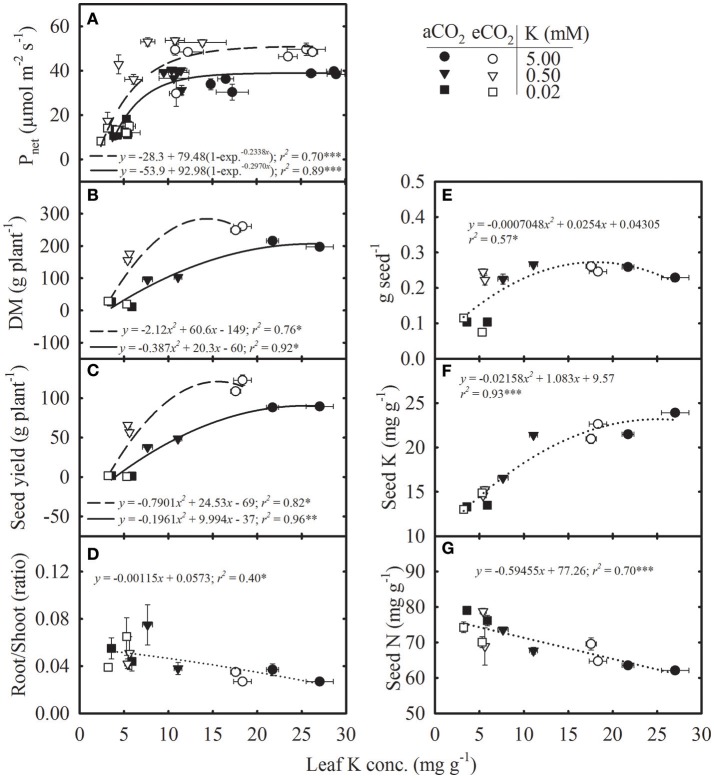
Relationship of leaf potassium (K) concentration with (A) photosynthesis (Pnet), (B) total dry matter (DM), (C) seed yield, (D) root/shoot ratio, (E) individual seed weight (g seed−1), (F) seed K concentration, and (G) seed nitrogen (N) concentration of soybean grown under ambient (aCO2; filled symbols/solid lines, 400 μmol mol−1) and elevated CO2 (eCO2; open symbols/dashed lines, 800 μmol mol−1) at three K levels. Symbols represent the mean ± SE of at least six individuals measured across the repeated experiment six times in the season in the uppermost fully expanded leaves (A) or from the destructive harvests at maturity (B–G). Lines are the fit of either exponential rise to maximum-3 parameters (A), polynomial second-order (B,C,E,F) or linear regression (D,G) equations. Dotted lines represent the fit across CO2 treatments. The significance level of the regression analysis for each equation is indicated as *, **, or *** representing P ≤ 0.05, P ≤ 0.01, and P ≤ 0.001, respectively. Error bars smaller than the symbols are not visible.